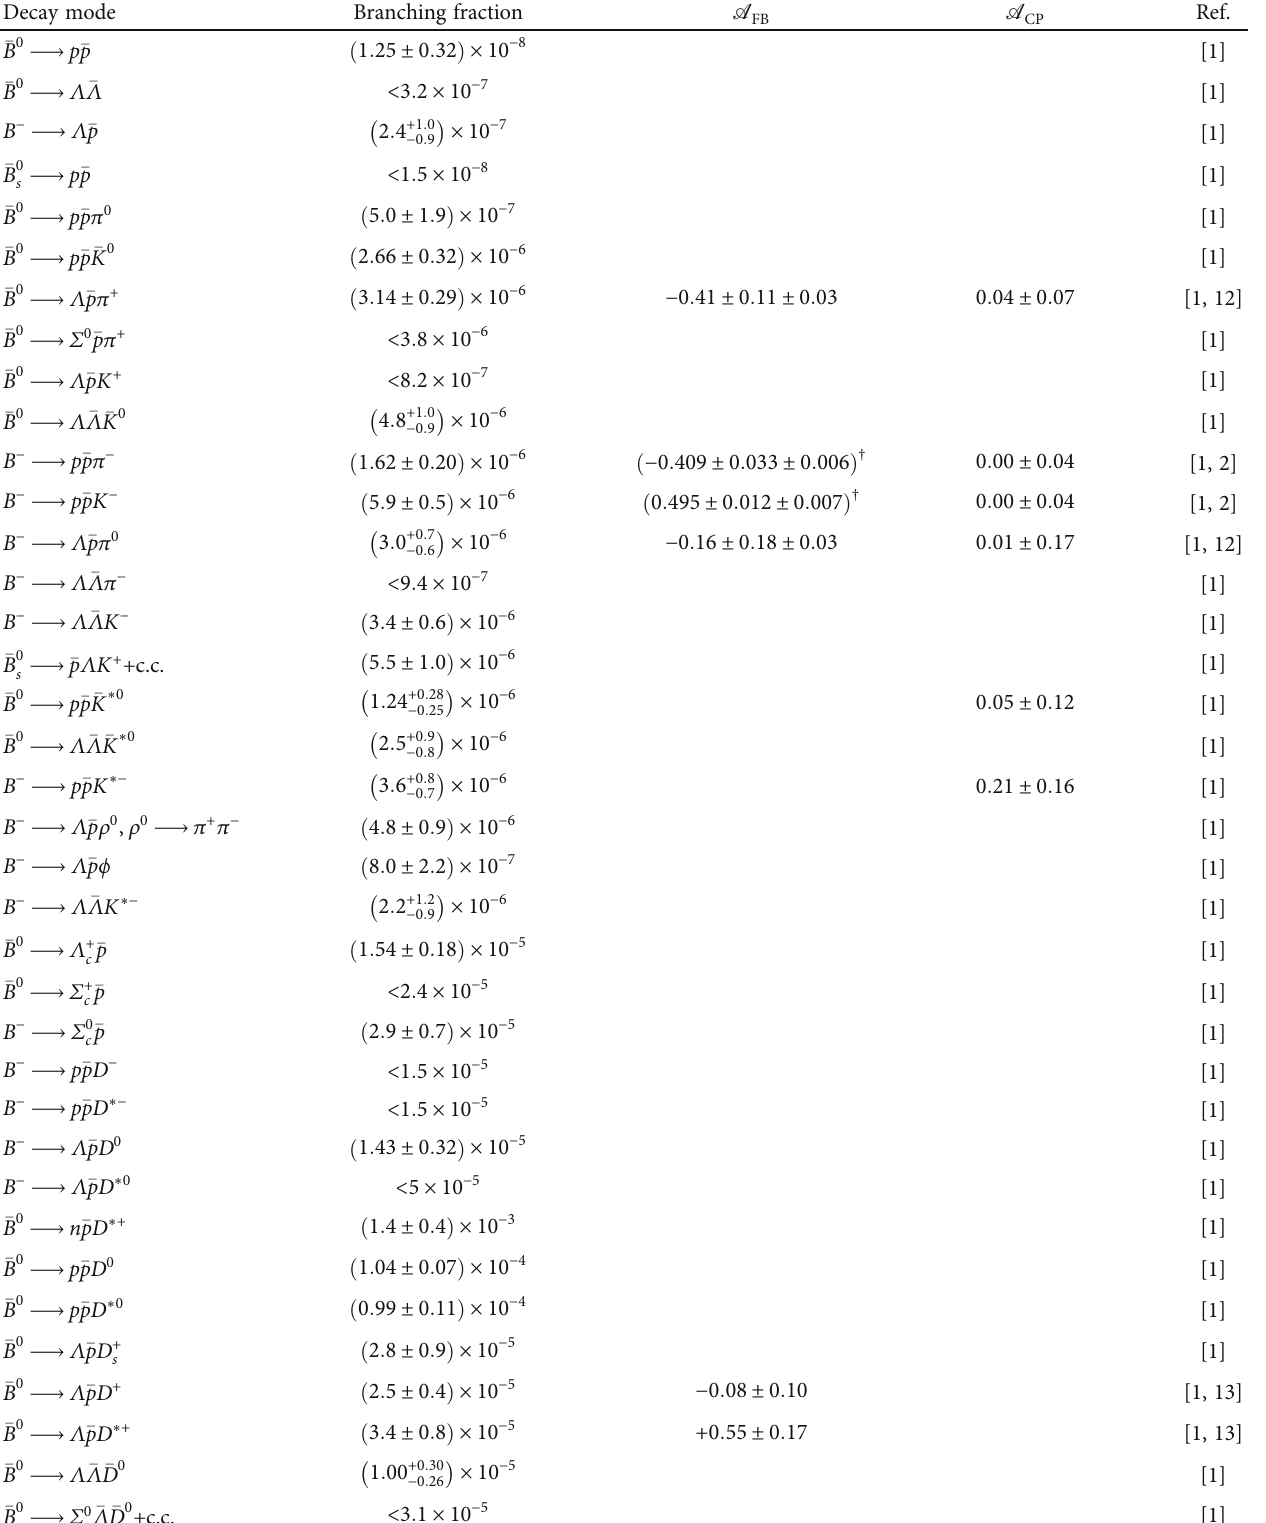
P asymmetries ( A Table 1: The measured branching fractions, forward-backward asymmetries ( A FB ), and C CP ) for the baryonic B decays, < 2 : 85 GeV. where the notation † is for A FB with m p (cid:1) p Decay mode Branching fraction A FB A CP